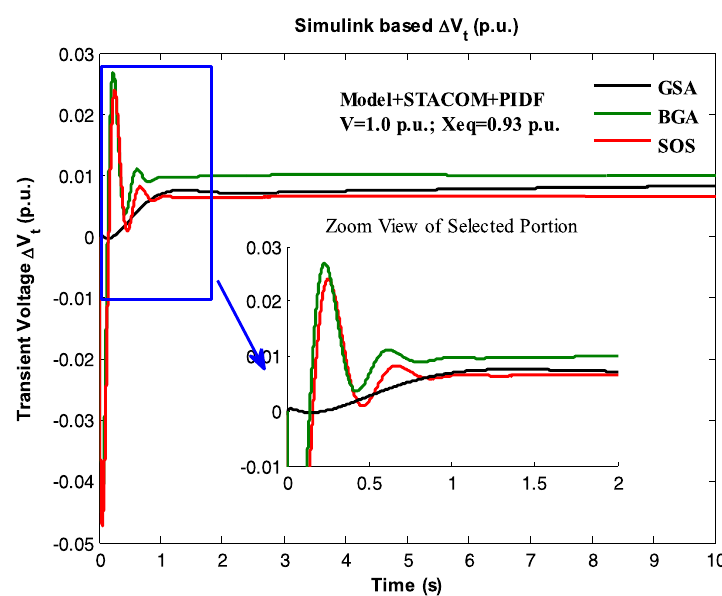
Table 2 Transient voltage parameters under different algorithms and load disturbances Input conditions Applied algorithms Peak time ( tp ) Rise time ( tr ) Steady state error ( Ess ) Overshoot ( Mp ) FOD